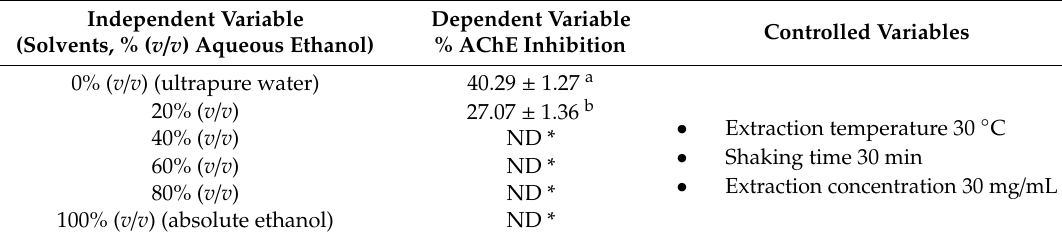
Table 1. E ff ects of di ff erent percentages of aqueous ethanol on MNCM extraction regarding AChE inhibition.